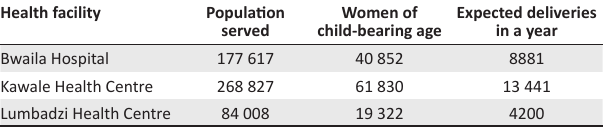
TABLE 1: Description of study